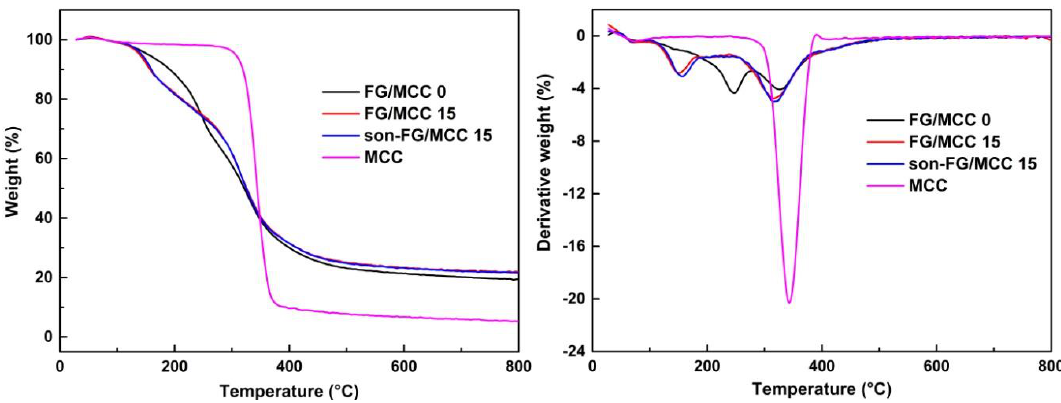
Figure 7. TGA and DTG curves of the FG/MCC 0, FG/MCC 15, and son-FG/MCC 15 composite films.